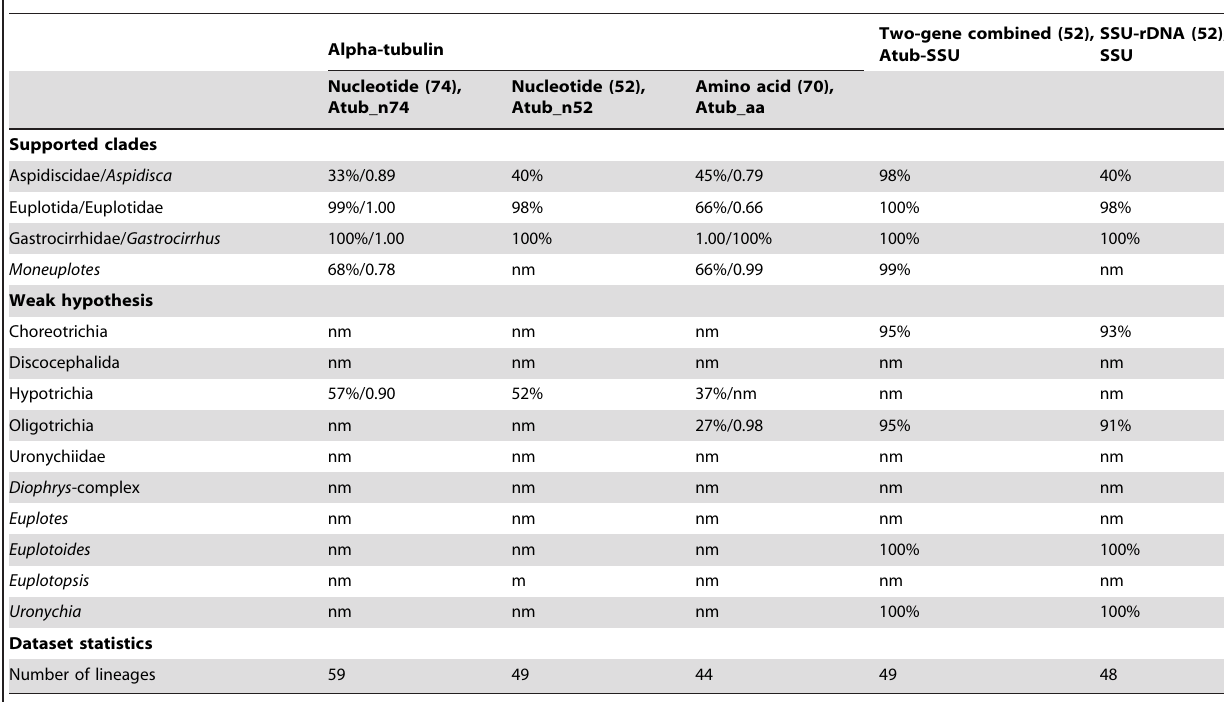
Table 3. Support for Major Clades of Spirotrichean Species in Analyses Based on Five